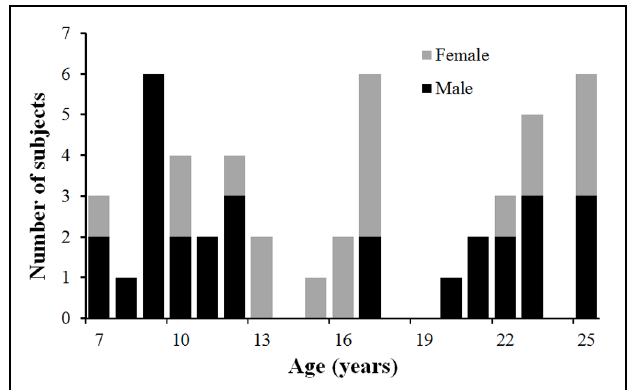
FIGURE 1 | The age and gender profile of the participated subjects. Males are in black and females in